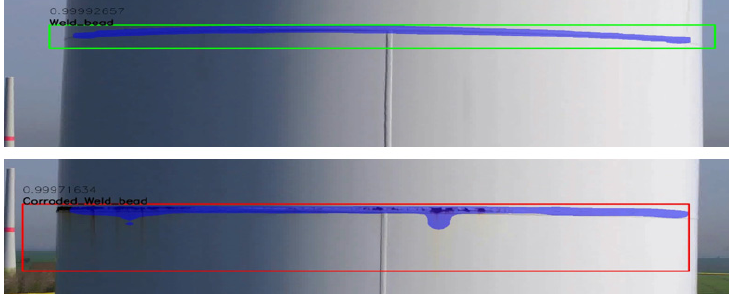
Figure 16. DCNN for the detection of corrosion.